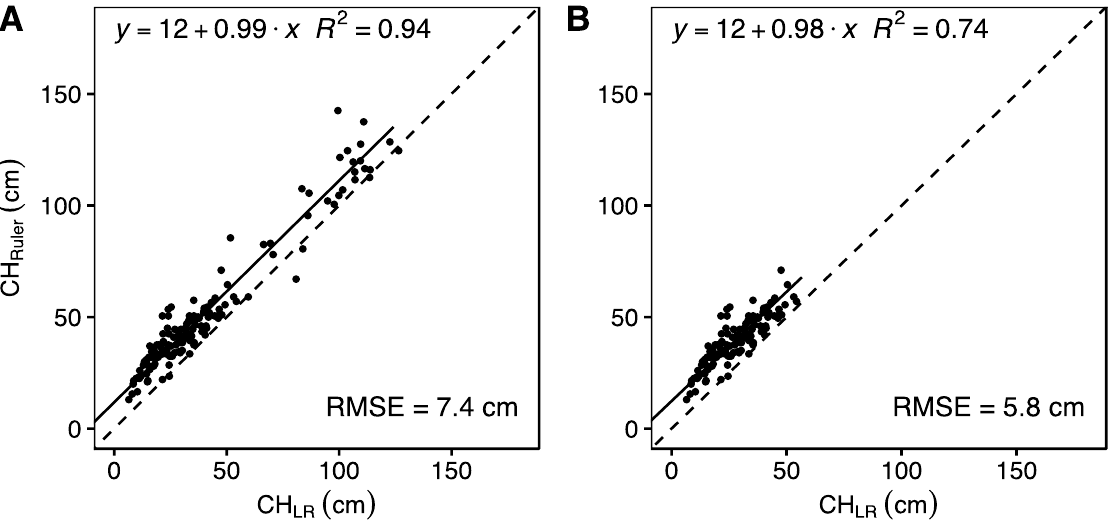
Figure 3. Linear relationship between canopy height from low-resolution UAV mission (CH LR ) and manual height measurement with a ruler-based method (CH Ruler ) of cover-crop treatments ( A ) for the whole dataset (n = 148) and ( B ) for the dataset excluding treatments containing mustard plants (n = 120).